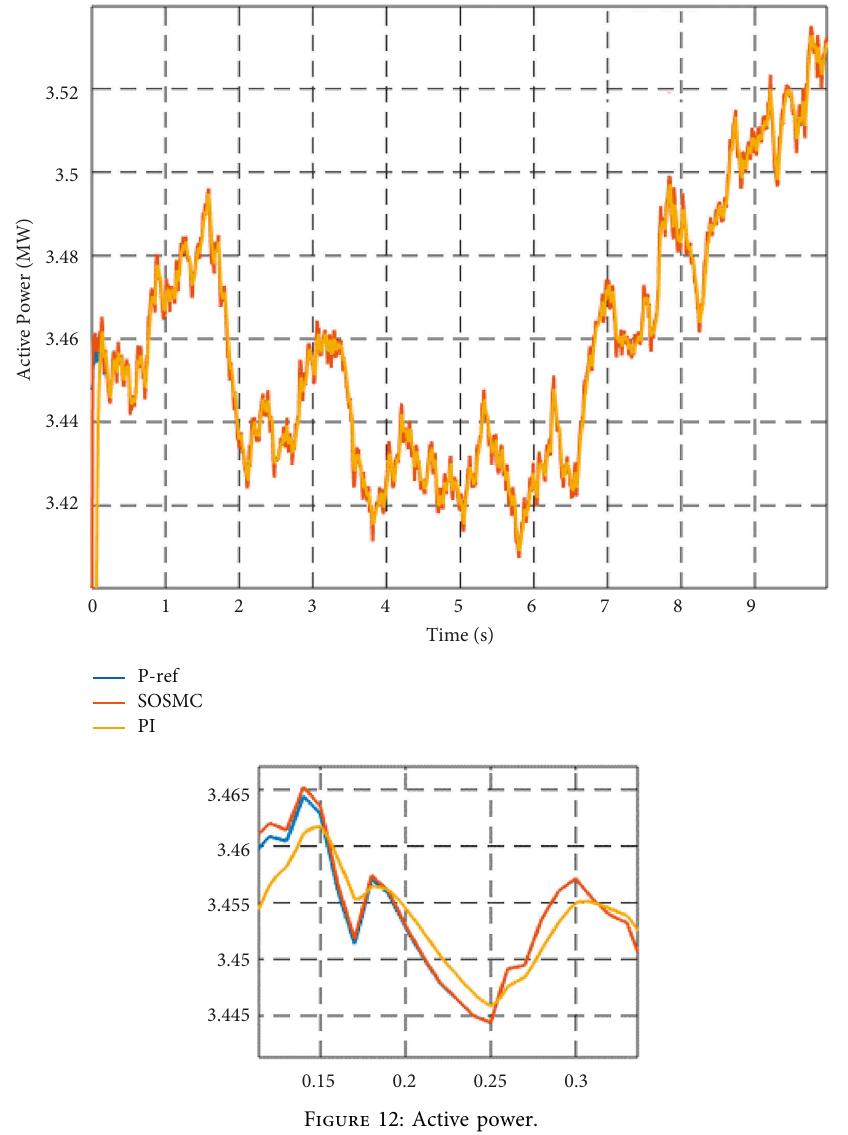
Figure 12: Active